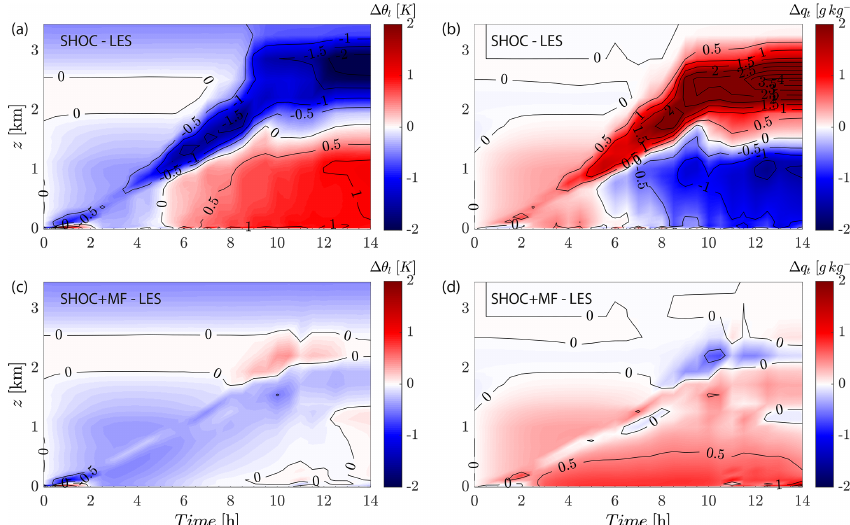
Figure 4. Time–height plot of liquid water potential temperature differences (cid:49)θ l between SCM and LES for (a) SHOC and (c) SHOC + MF as well as total water mixing ratio differences (cid:49)q t for (b) SHOC and (d) SHOC + MF for the ARM shallow cumulus case. The LES temporal and vertical grids were interpolated to the SCREAM grids before calculating the differences.